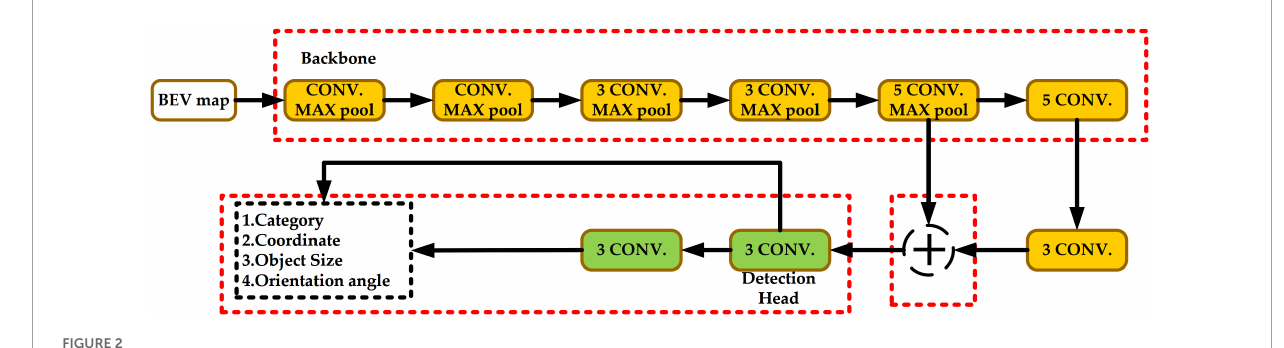
FIGURE2 Complex-YOLO network structure.